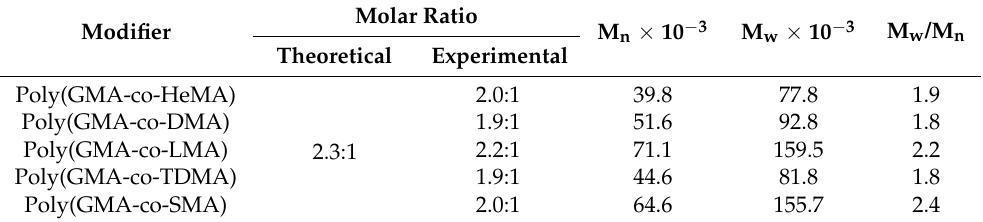
Table 1. Composition and molecular weight characteristics of GMA and AlMA copolymers.